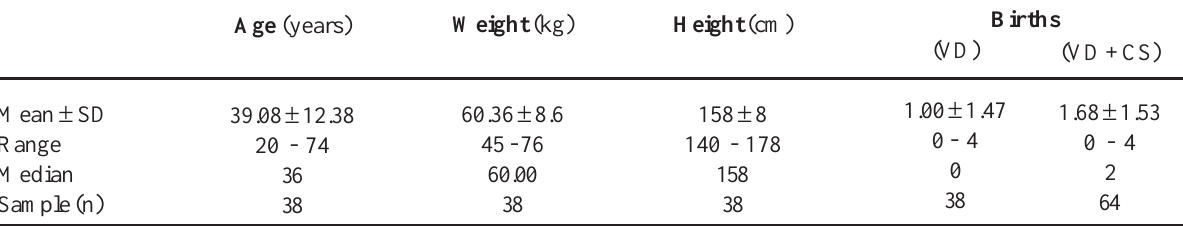
VD = number of vaginal delivery; CS = number of cesarean